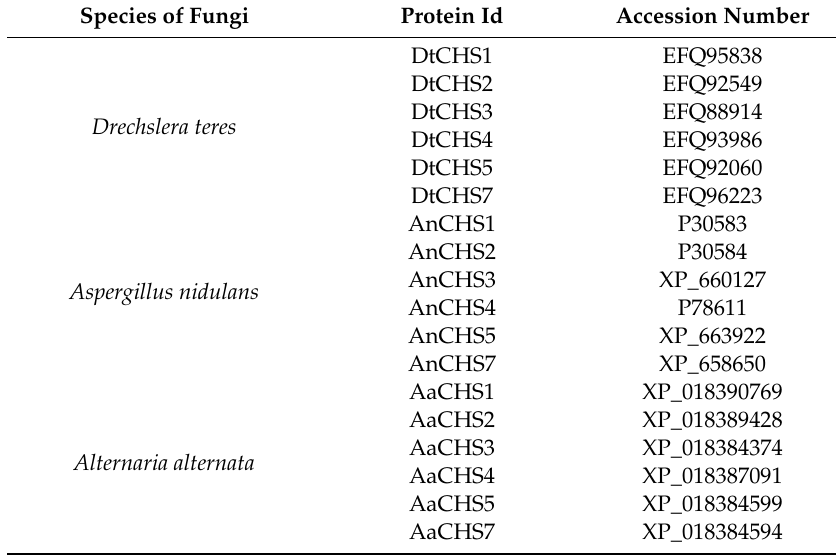
Table 1. List of the chitin synthase (CHS) protein accession numbers from the species used in this study. Species of